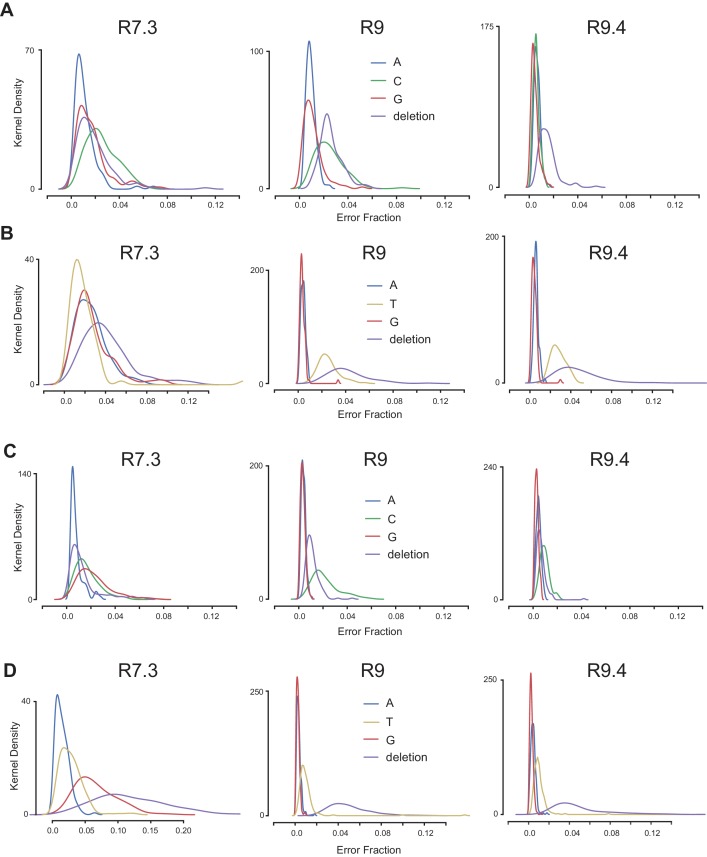
Error rate profiles in ONT reads.The proportions of non-reference bases aligned to the 5-mers containing the K3LWT (A), K3LHis47Arg (B), E9LWT (C), or E9LGlu495Gly (D) sequences were calculated from alignments of ONT reads from the P15 population generated with three distinct flowcell chemistries (listed above each plot). Kernel density plots represent the distributions of error proportions for each non-reference base across all 5-mers in the vaccinia reference genome.